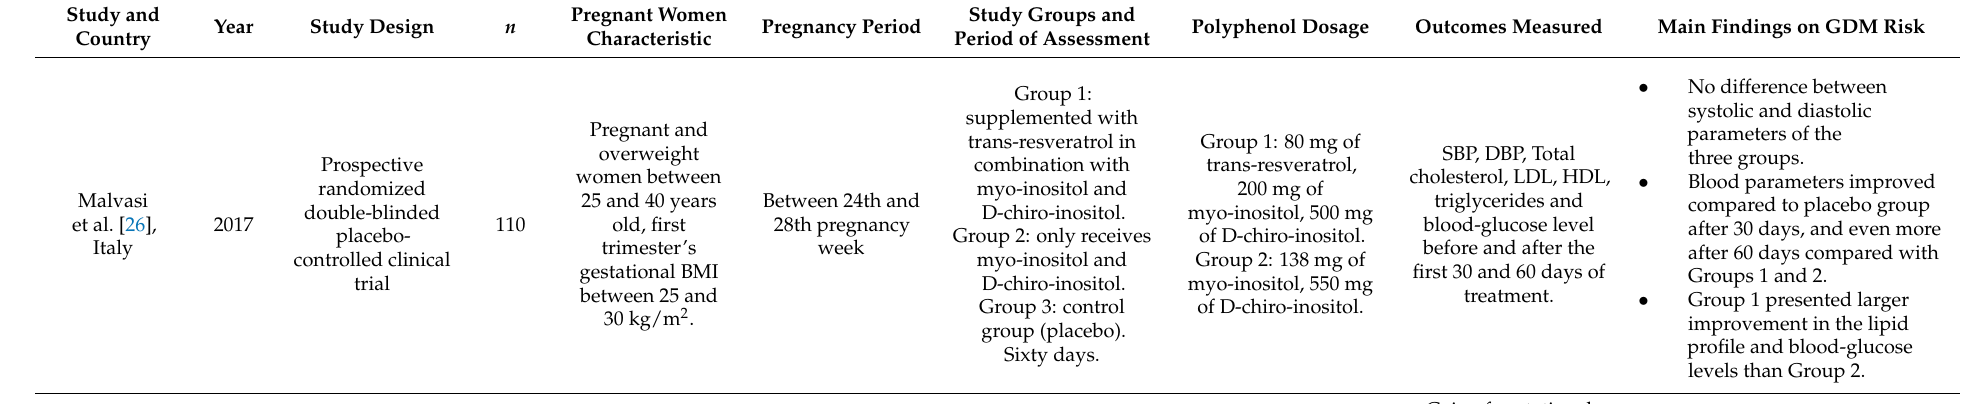
Table 1. Characteristics of studies in the effect of polyphenol intake regarding the possibility of developing